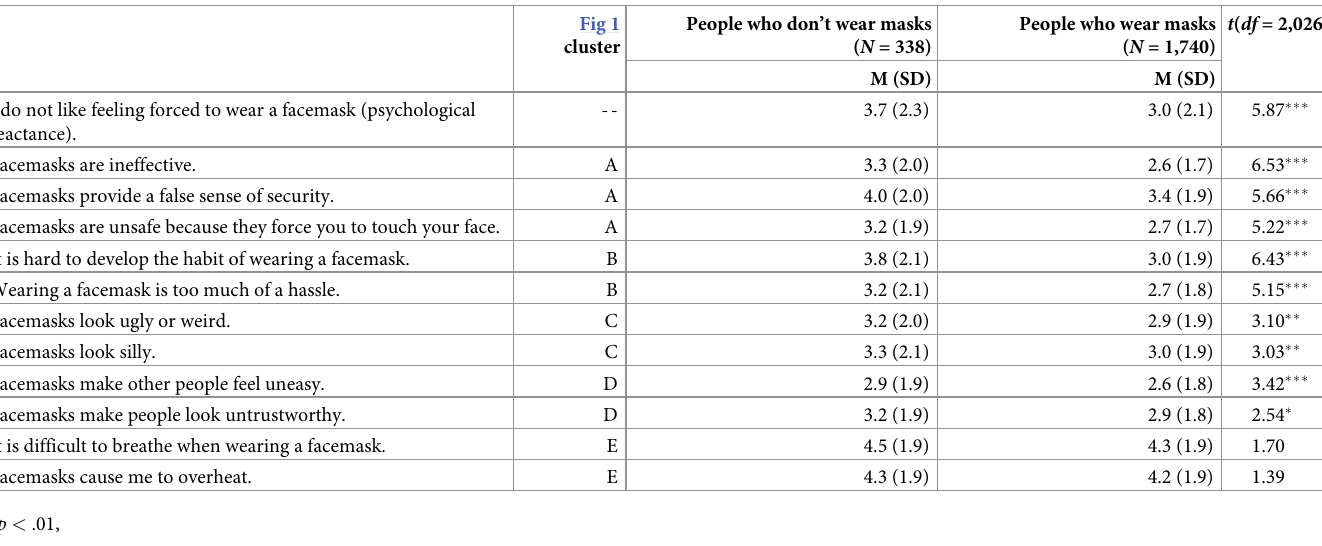
Table 1. Scores on measures of negative attitudes towards facemasks.